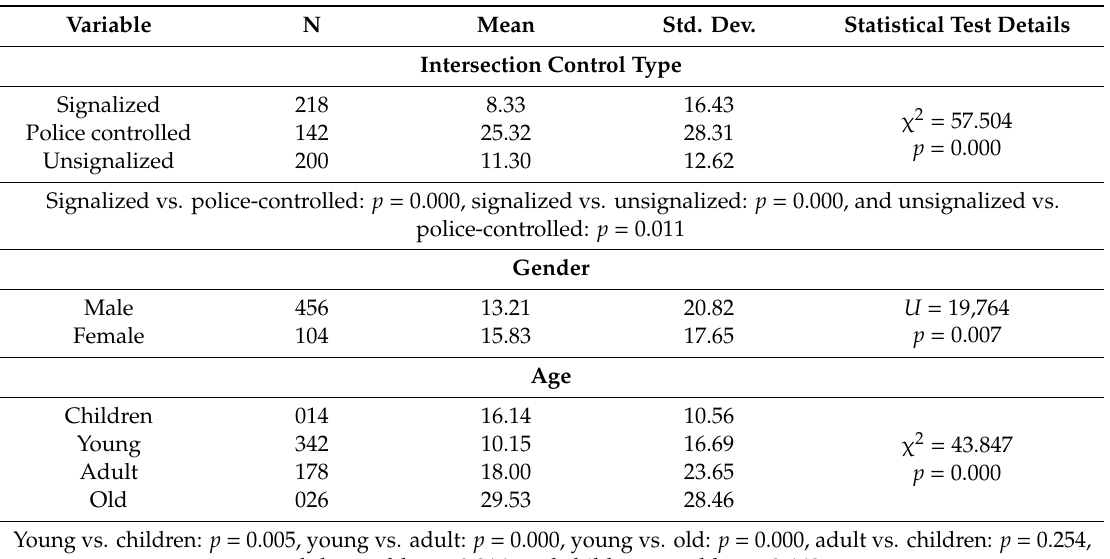
Table 7. Results of statistical analysis between waiting time and factors influencing